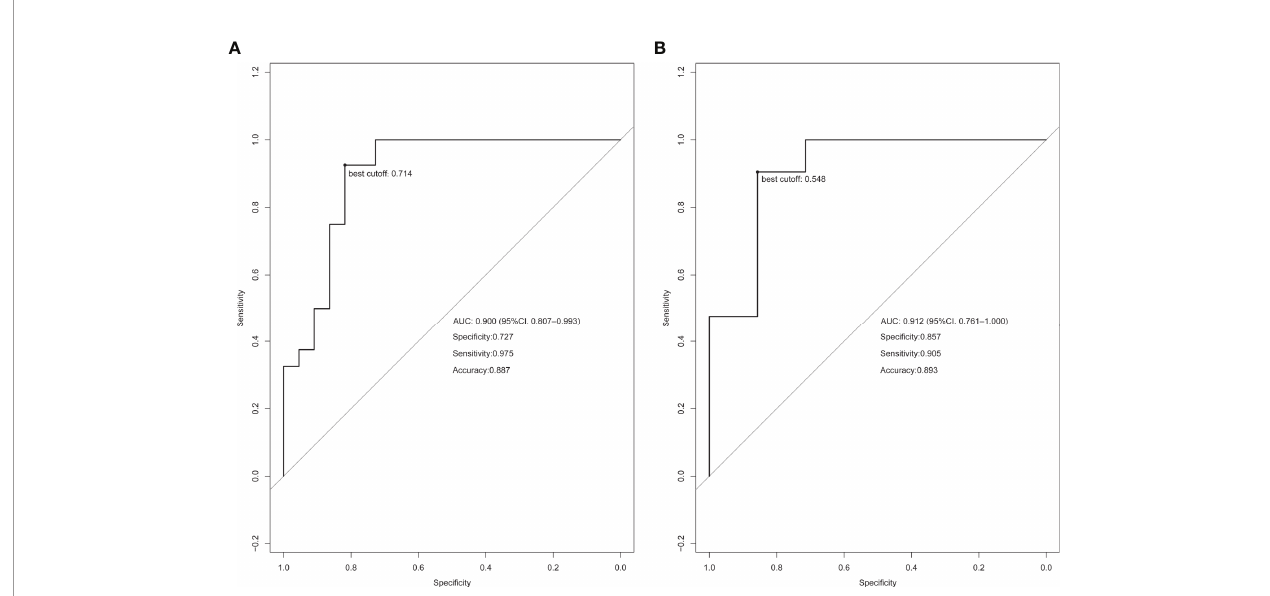
FIGURE 3 | Receiver operating characteristic (ROC) curve analysis based on the model prediction. The best cutoff values are indicated on the curves. (A) ROC curve of the training cohort. (B) ROC curve of the validation